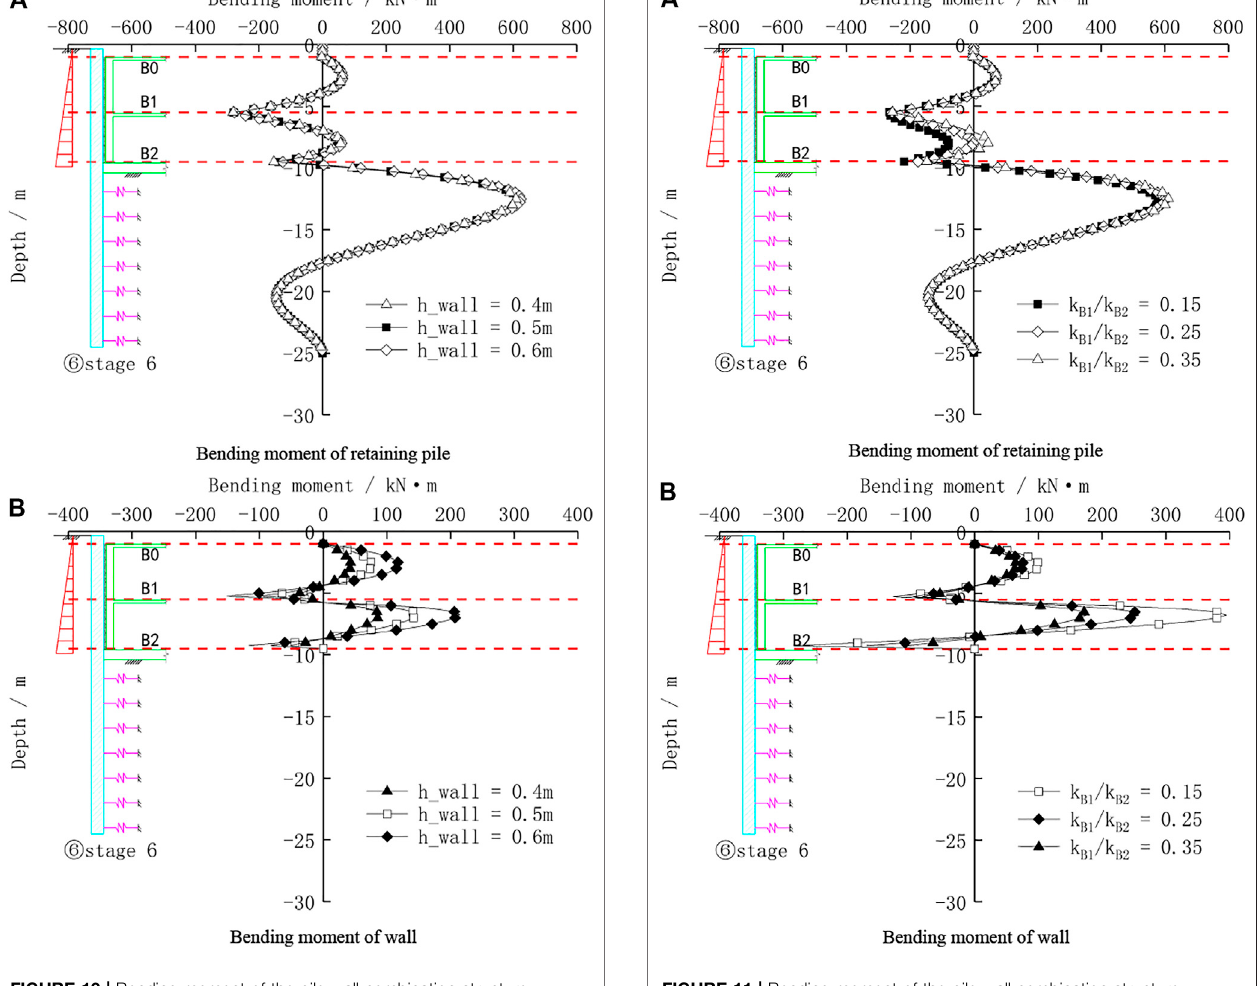
FIGURE 10 | Bending moment of the pile wall combination structure withdifferentpilewallstiffnessratios. (A) Bendingmomentoftheretainingpile. (B) Bending moment of the wall.